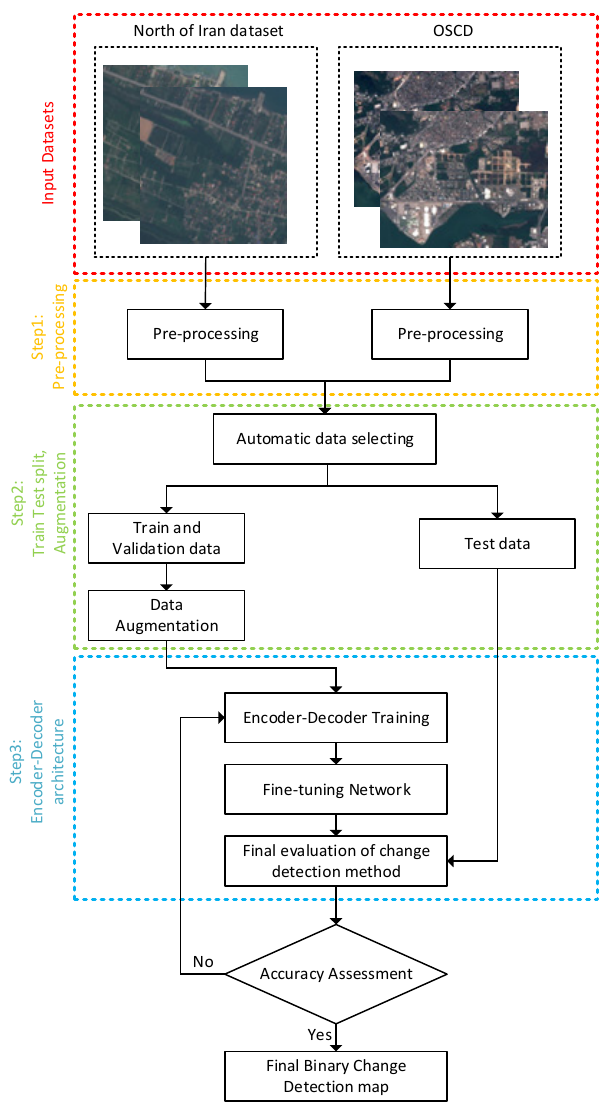
Figure 3. Flowchart of the proposed method.